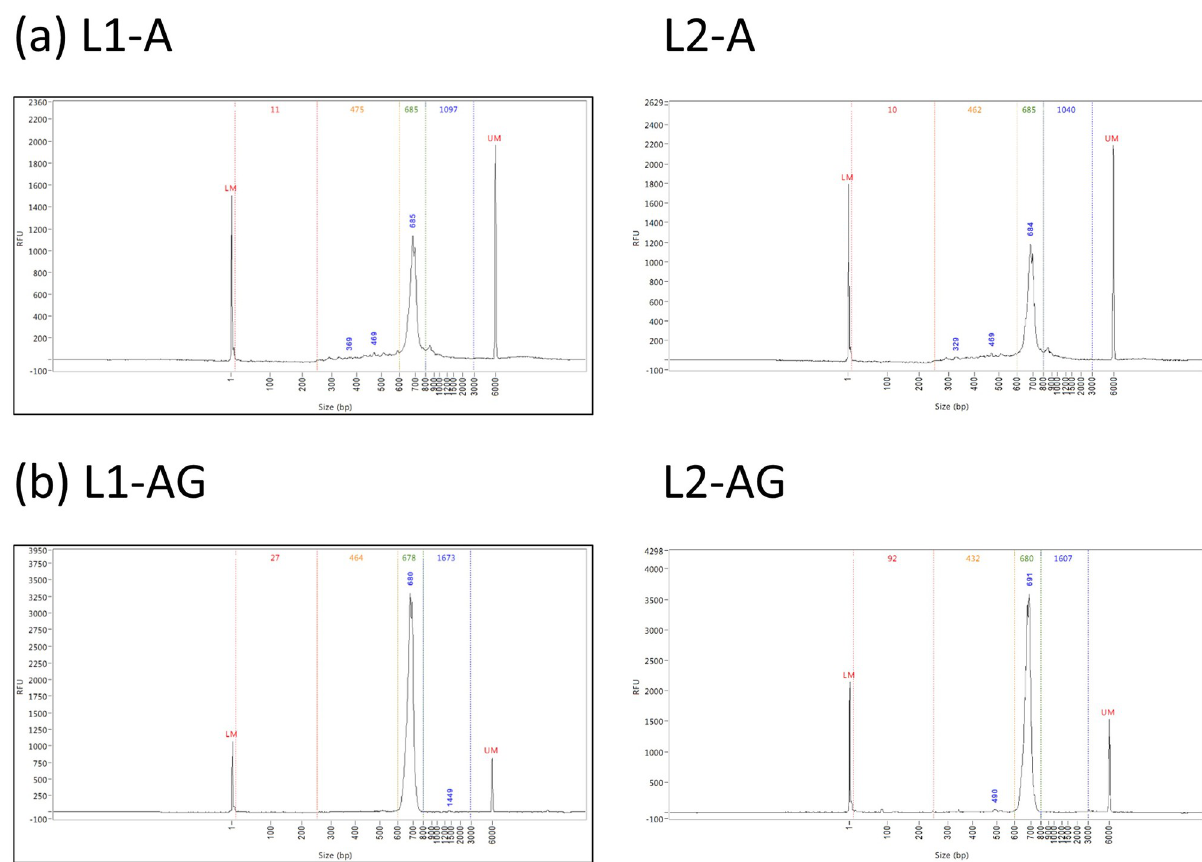
Fig 2. Fragment length distributions of 5’-RACE libraries constructed using protocol (a) A and (b) AG from blood sample of individual L. The two columns (L1 and L2) show results of the two technical repeats respectively.